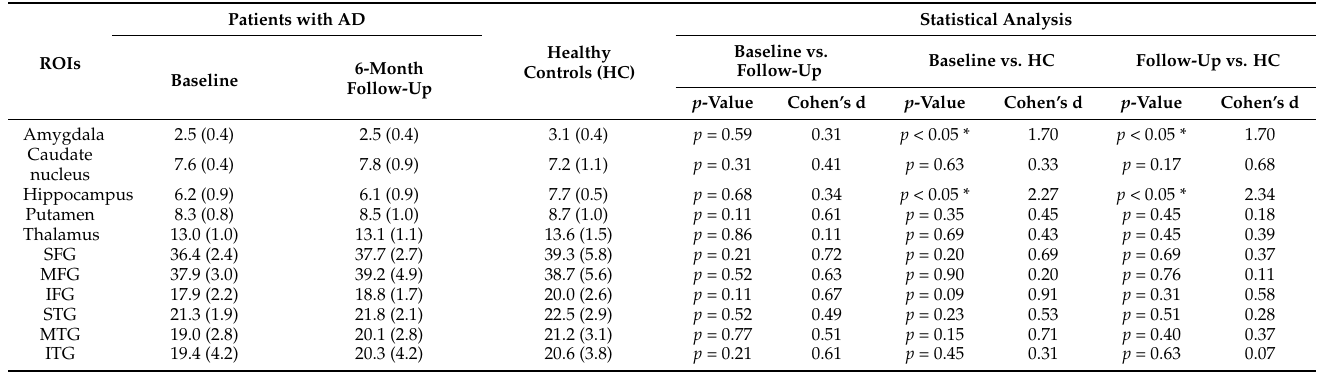
Table 1. Differential brain volumes in the patients with early AD (baseline and 6-month follow-up) and healthy controls.